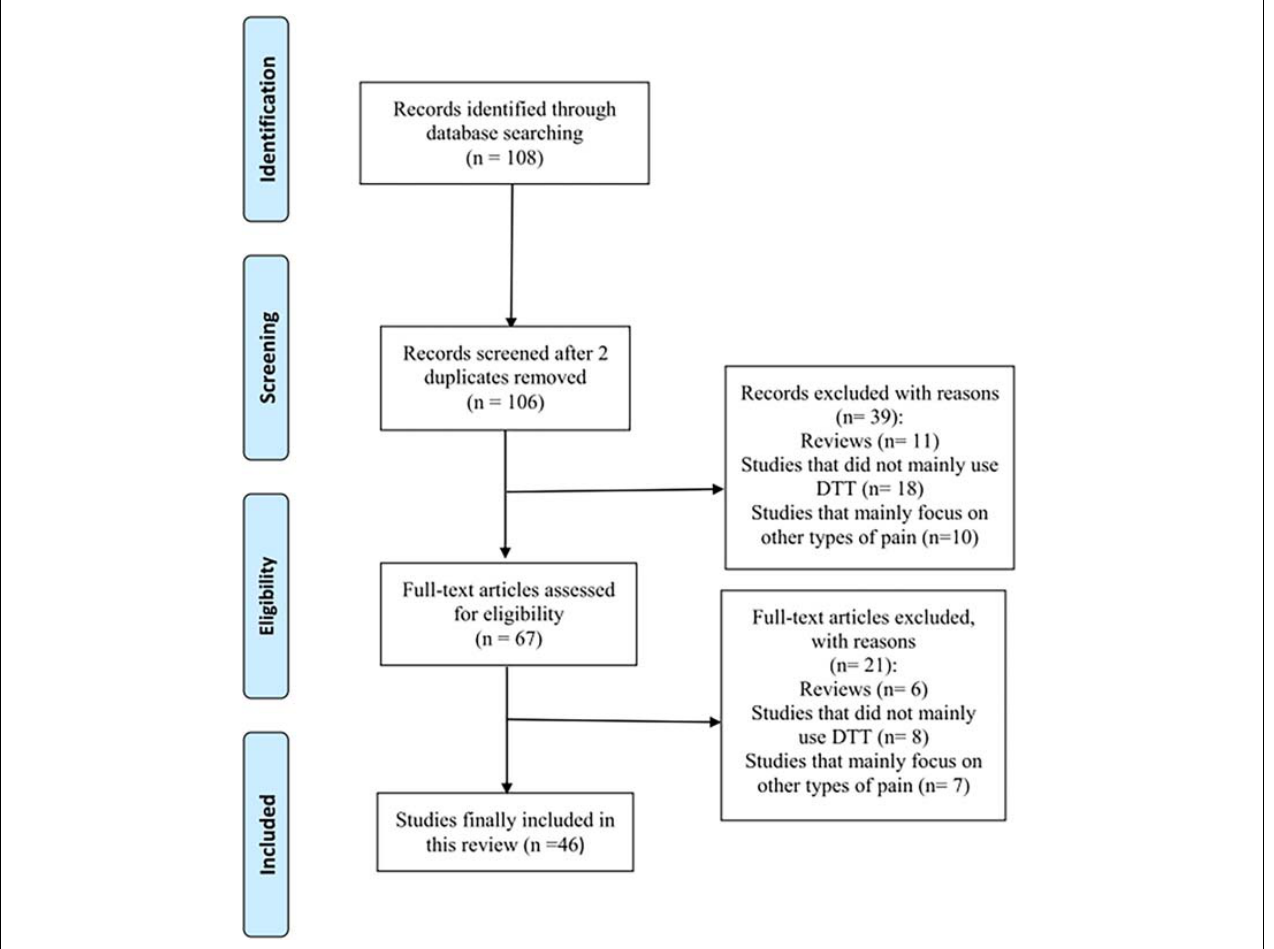
FIGURE 1 | Flow diagram of the study selection process. DTT, diffusion tensor